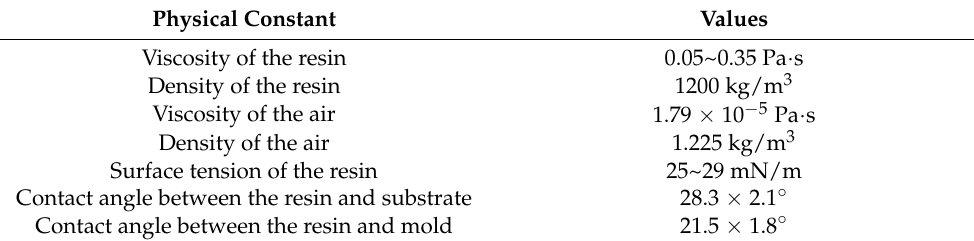
Table 1. Physical parameters in the filling simulation